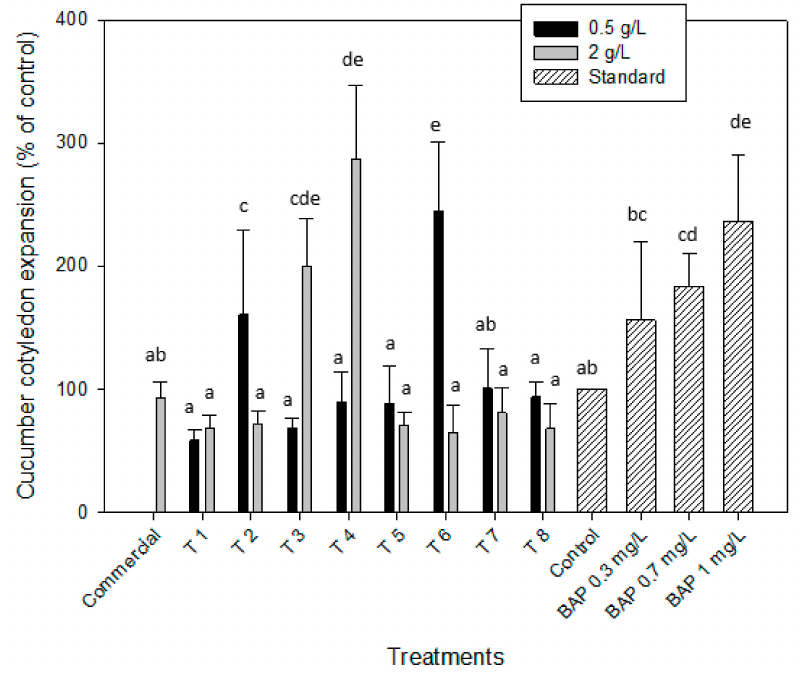
Figure 4. Cytokinin-like activity of Scenedesmus obliquus biomass when applying the excised cucumber cotyledon root expansion bioassay for the eight microalgal treatments (T1–T8) at the two concentration tested (0.5 and 2 g / L) and using BAP at 0.3, 0.7 and 1 mg / L as the cytokinin standard. Results are shown as mean ± SE ( n = 3). Di ff erent letters indicate significant di ff erences ( p < 0.05) within each